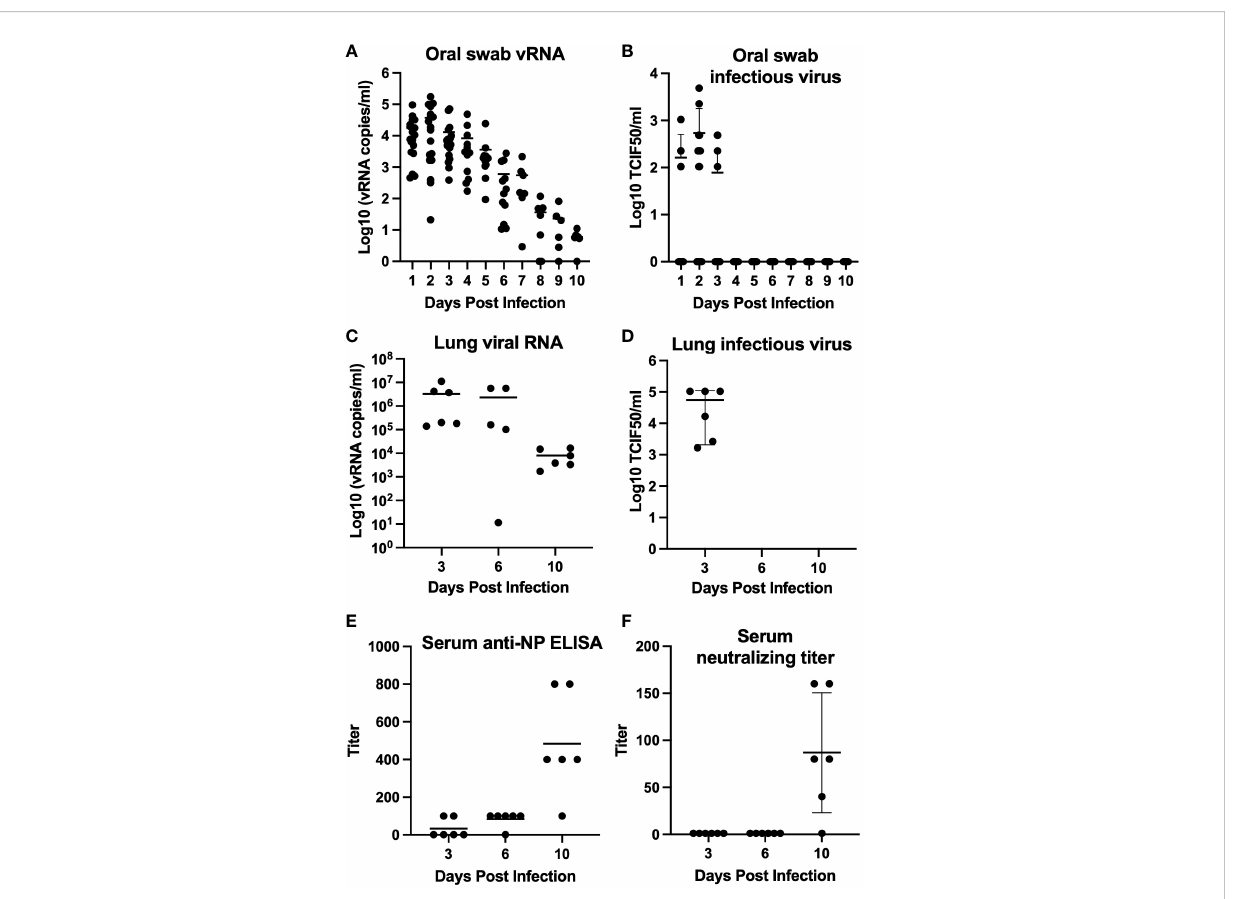
FIGURE 2 Mean virus detection and serology for California mice ( P. californicus insignis) . Oral swabs collected daily (days 0 – 10 post-challenge) (n=18 for days 0-3, n=12 for days 4-6, n=6 for days 7-10) were tested for viral RNA (A) and infectious virus (B) . Lung homogenate collected from mice euthanized on days 3 (n=6), 6 (n=6), and 10 (n=6) post-challenge were also tested for viral RNA (C) and infectious virus (D) . Serum collected from mice on days 3 (n=6), 6 (n=6), and 10 (n=6) post-challenge was evaluated for quanti fi cation of serum IgG determined by indirect ELISA (E) and serum neutralizing antibody titer determined by serum neutralization assay (F) .